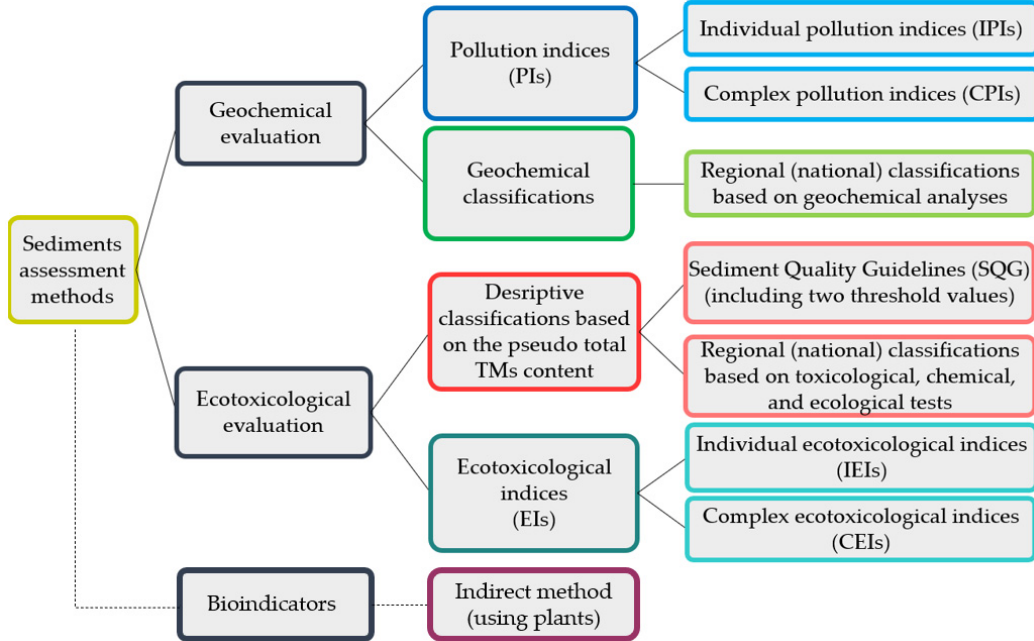
Figure 1. Division of the methods of assessment of sediment contamination with PTEs.